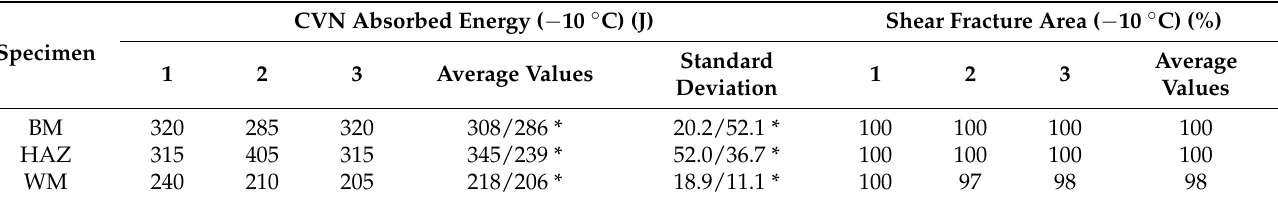
Table 3. CVN impact properties of the